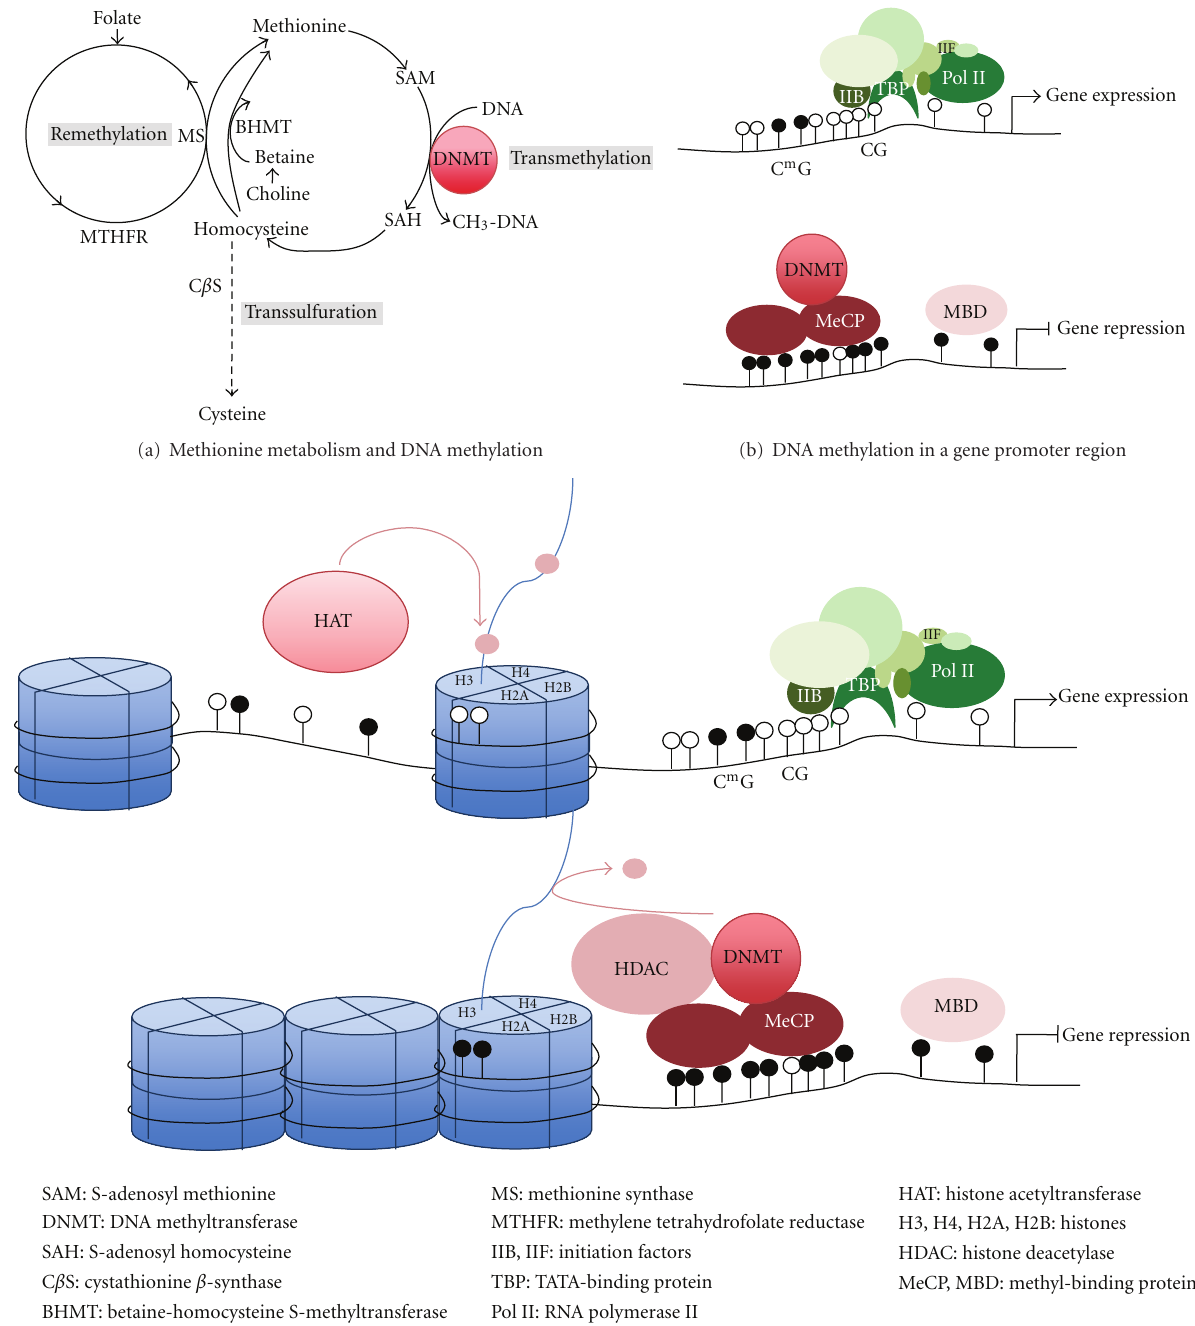
Figure 1: Schematic figure of epigenetic regulation